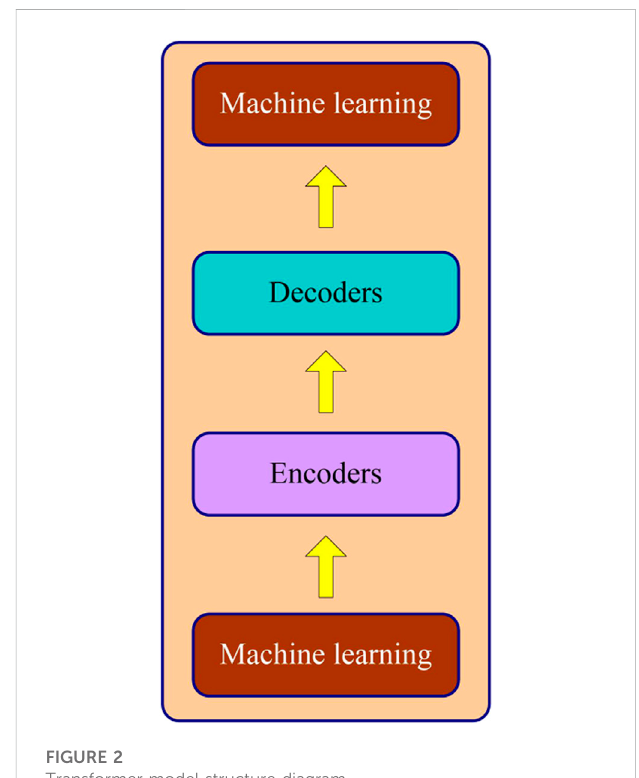
FIGURE 2 Transformer model structure